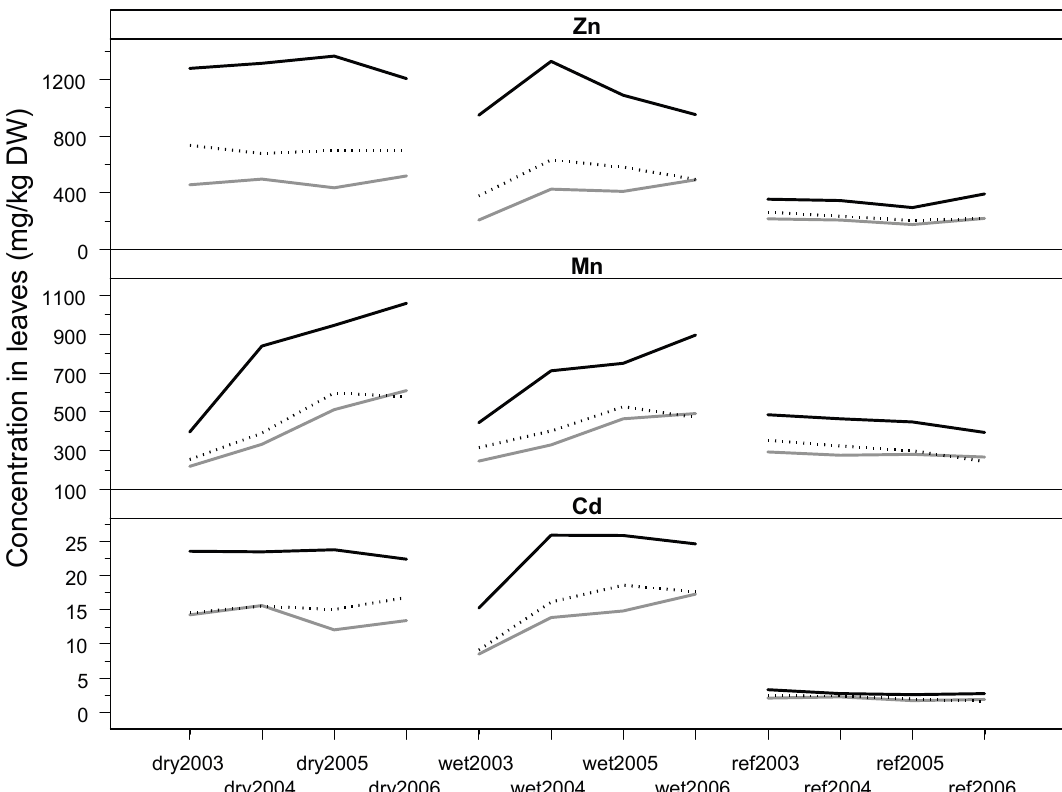
Figure 3. Trends in foliar concentrations between 2003 and 2006 in the early (gray line), middle (dotted line) and late growing season (black line) for Cd, Zn and Mn for the reference plot (ref, Plot 0), the plots already emerged in 2003 (“dry”, Plots 1 + 2 + 3) and the plots still submerged in 2003 (“wet”, Plots 4 + 5 + 6) (DW: dry